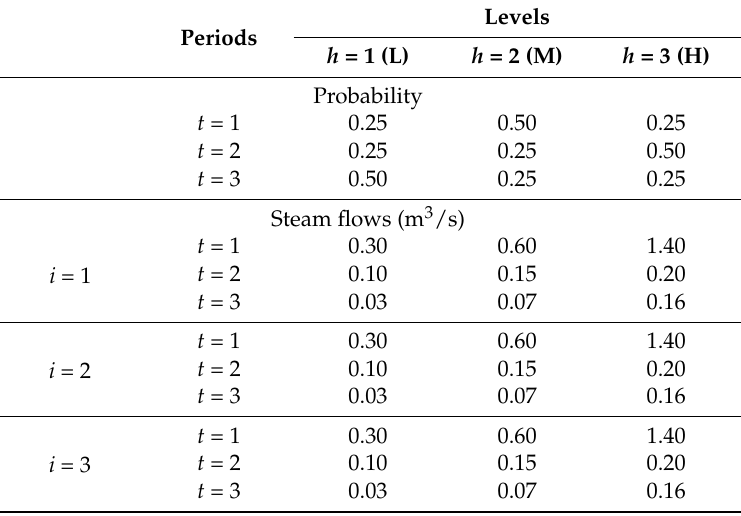
Table 2. Stream flows of the Yitong River in the three